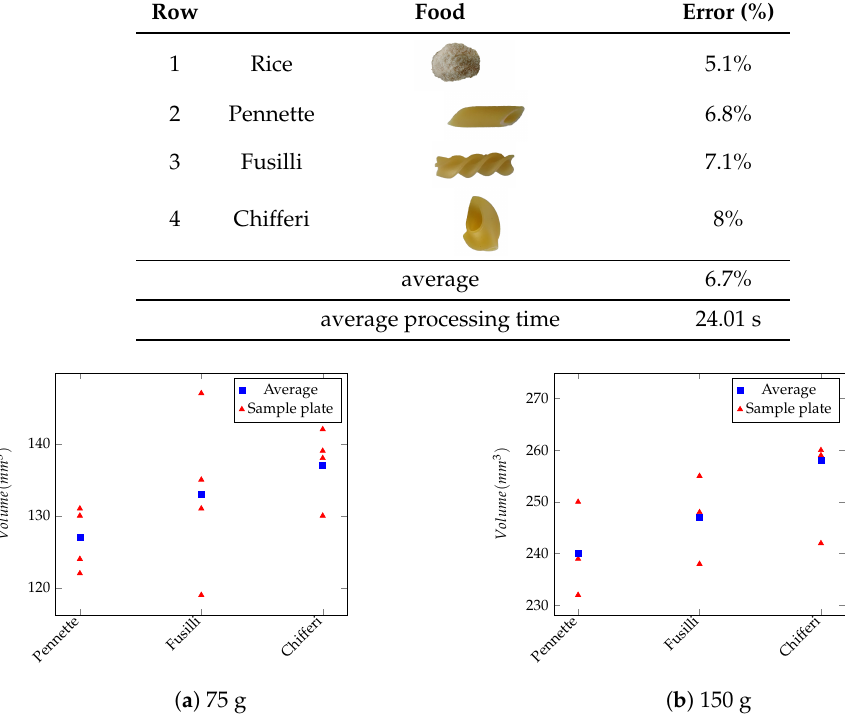
Figure 7. Calculated volume for ( a ) 75 g and ( b ) 150 g of different types of pasta. For each type, the calculation was repeated four times on two different dishes.